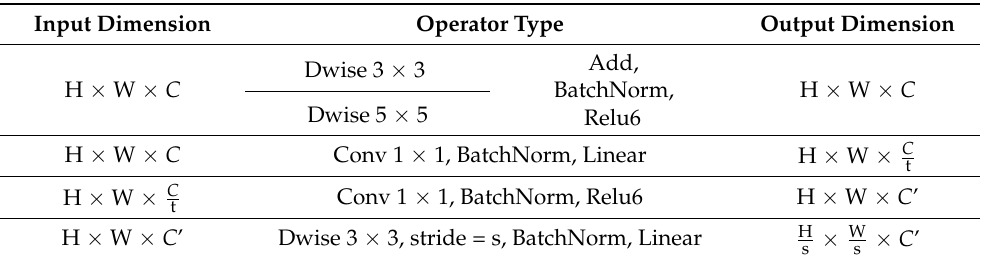
Figure 2. Two different iris feature extraction modules: ( a ) iris-feature module1; ( b ) iris-feature module2. Table 1. The structure details of the iris-feature modules. t: channel reduction factor; s: stride; C: number of input channels; C ’ : number of output channels.